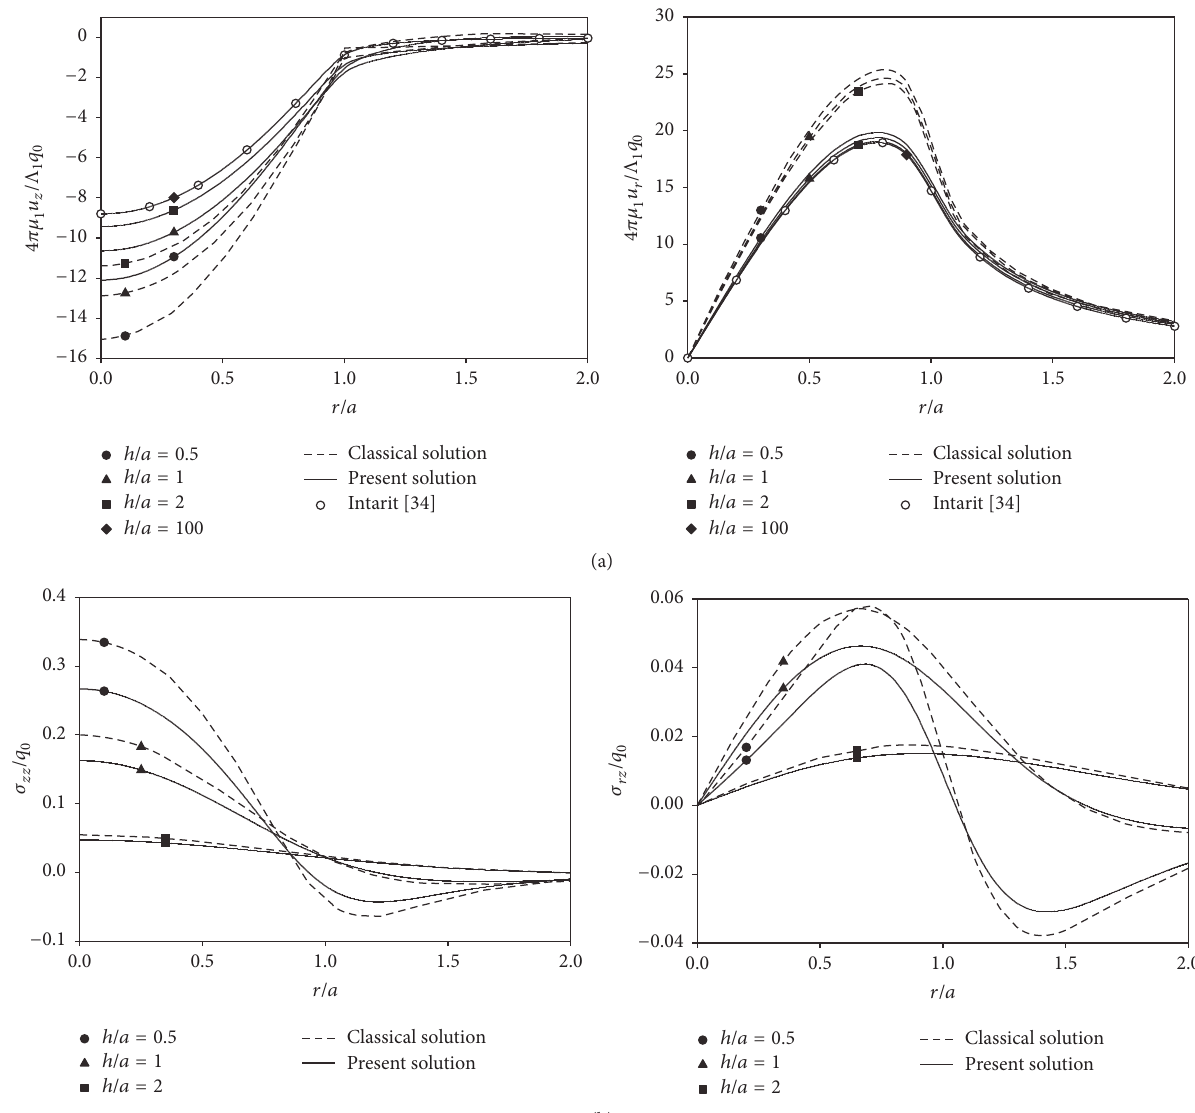
Figure 5: Radial variations of elastic fields under the radial loading for different values of layer thickness (ℎ/𝑎) : (a) surface displacements (𝑧 = 0) and (b) stresses at the interface (𝑧 = ℎ) .